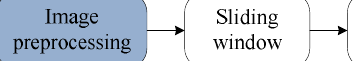
Figure 3. Traditional target detection algorithm.